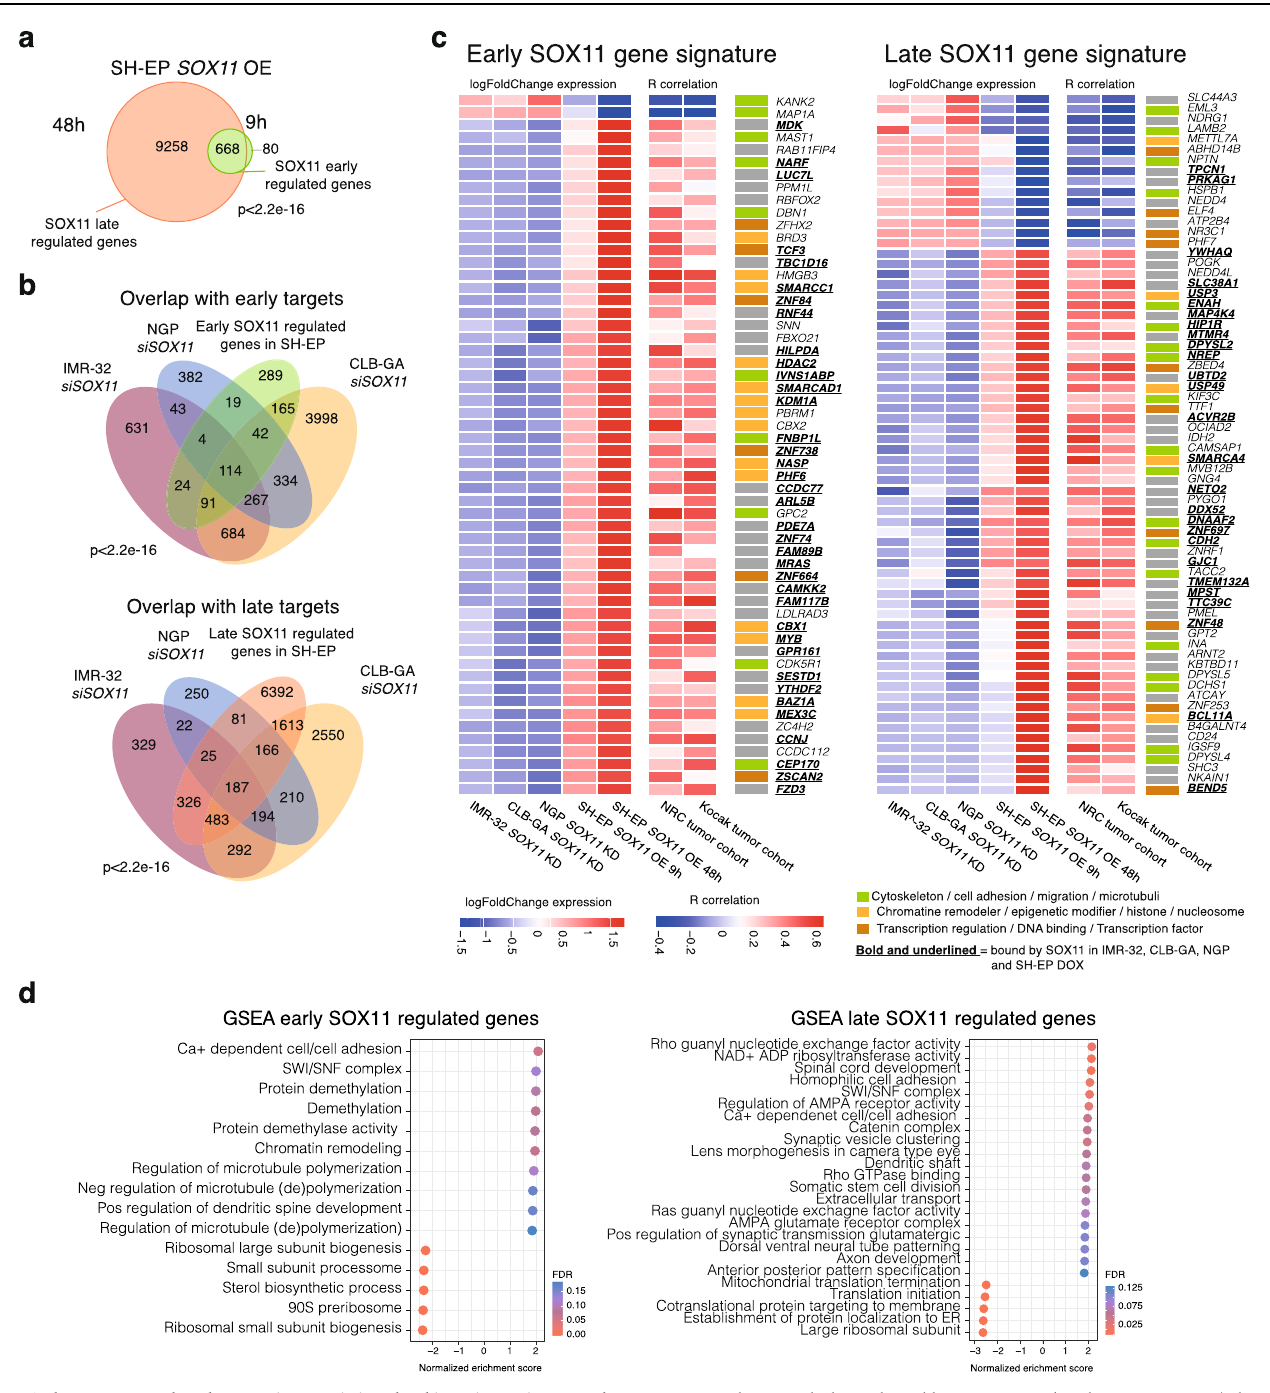
Fig. 4 | The SOX11 regulated transcriptome is involved in epigenetic control, cytoskeleton and neurodevelopment. a Overlap of genes perturbated in SH-EP upon SOX11 overexpression (OE) for 48h and 9h (adj p value <0.05) with differ- ential genes upon 9h overexpression being the SOX11 early regulated genes and differential genes upon 48h but not 9h overexpression being the SOX11 late regulated genes (one-tailed fi sher test p -value <2.2e − 16 ). b Overlap of genes per- turbated in IMR-32, CLB-GA and NGP upon SOX11 knockdown for 48h (adj p value <0.05) with respectively the SOX11 early and late regulated genes in SH-EP (one- tailed fi sher test p -value <2.2e − 16 ). c SOX11 early and late genes signature obtained bytheoverlapof differentiallyexpressedgenesupon SOX11 knockdowninIMR-32,